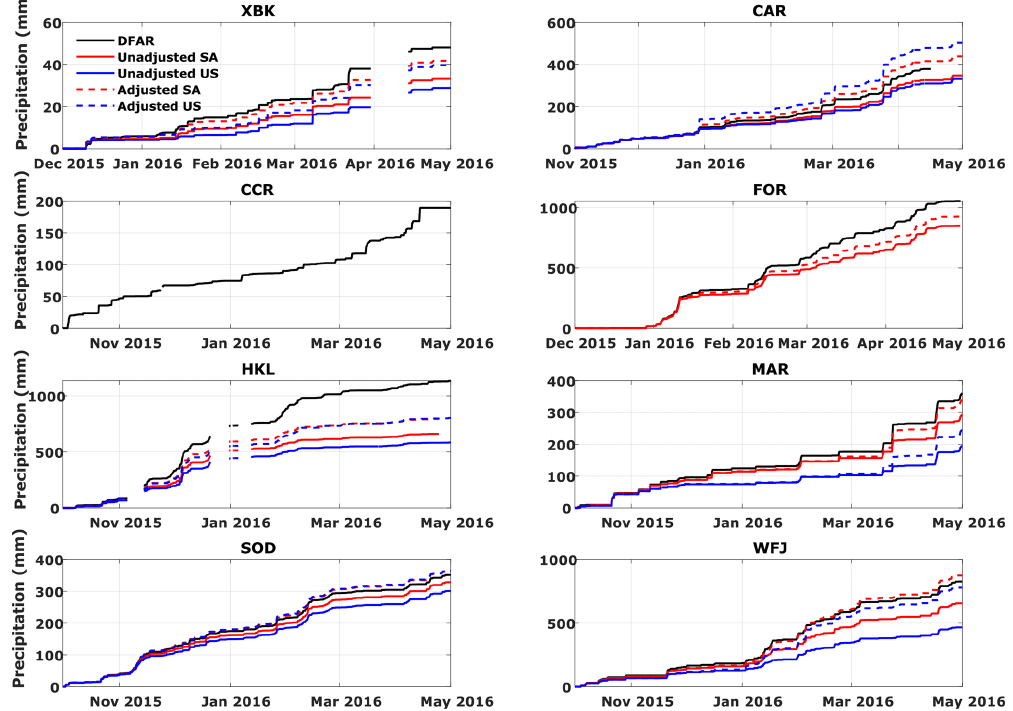
Figure 3. Time series of unadjusted (solid) and adjusted (dashed) precipitation time series for single Alter-shielded (red) and unshielded (blue) gauges as compared to the DFAR (black) during the 2015/2016 winter season at the eight SPICE sites.